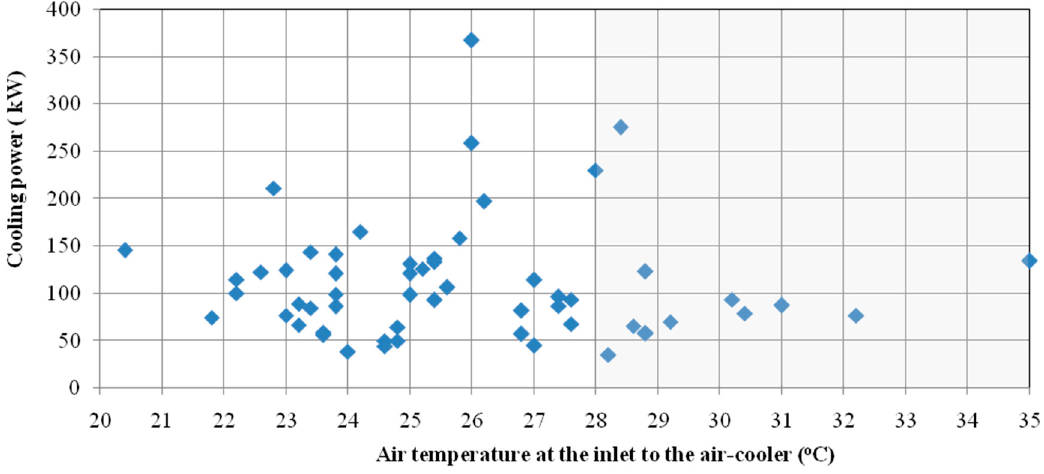
Figure 10. The relationship between the cooling capacity and the air temperature at the inlet to the spot